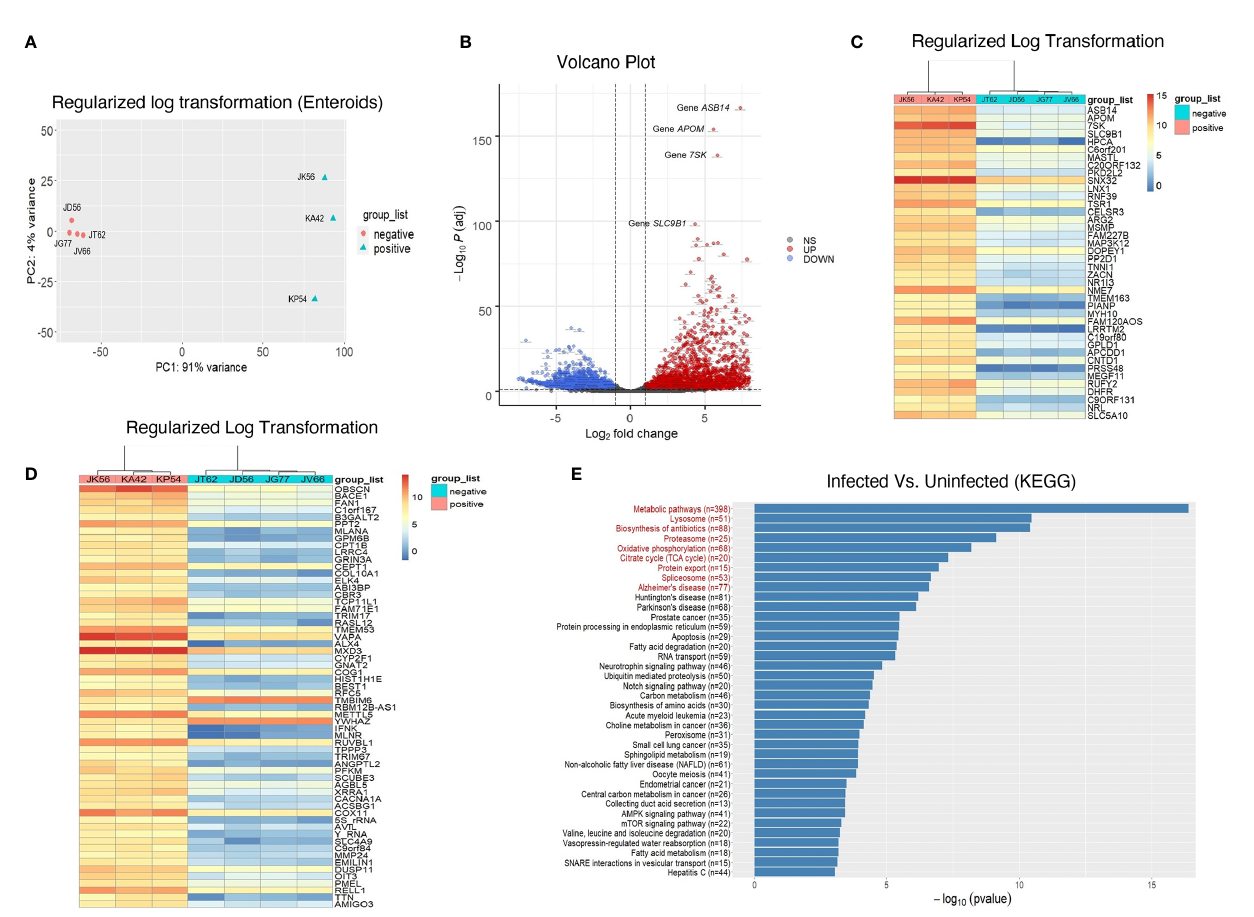
FIGURE 5 | Transcriptomic pro fi ling of rhesus enteroids isolated from chronically SIV-infected and SIV-uninfected RhMs . (A) PCA plot of 4 normal SIV-uninfected (JT62, JD56, JG77, and JV66) and 3 chronically SIV-infected (JK56, KA42, and KP54) RhMs show the characteristics of samples according to the gene expression levels. (B) Volcano plot of the upregulated and downregulated DEGs of SIV-infected and uninfected RhMs. The X-axis and Y-axis represent the log 2 fold change and negative log 10 adjusted p-values, respectively. Genes with an FDR of less than 0.05 found with DEseq2 were assigned as differentially expressed. Red and blue dots indicate signi fi cantly upregulated and downregulated genes, respectively. Heatmaps of read counts of the top 40 (C) and next 60 genes (D) from enteroids which have the smallest adjusted p-values and the regulation function using the shifted logarithm transformation. (E) The results for the pathway enrichment analysis based on KEGG database. There are 38 signi fi cantly enriched pathways whose p-values were <0.05 without the correction of multiple comparisons. The red enriched pathways indicate that those pathways are enriched with the p-value adjusted by the Benjamini-Hochberg (BH) FDR below the signi fi cance level of